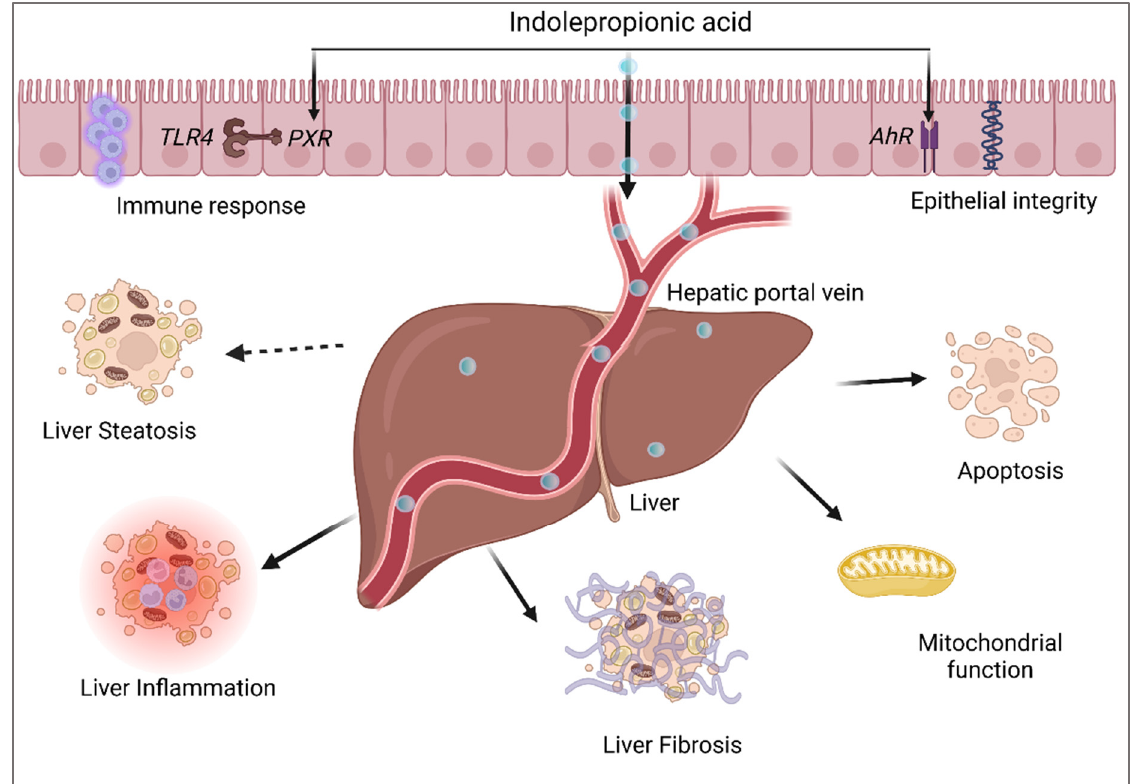
Figure 6. Overview of beneficial effects of IPA on intestinal dynamics and NAFLD. IPA can serve as a ligand for AhR and PXR in the intestinal epithelial cells leading to enhanced epithelial integrity and immune response (via TLR4 ), respectively. IPA can gain access to the liver directly via the hepatic portal vein and has been shown to be actively involved in liver inflammation, fibrosis, mitochondrial function, and